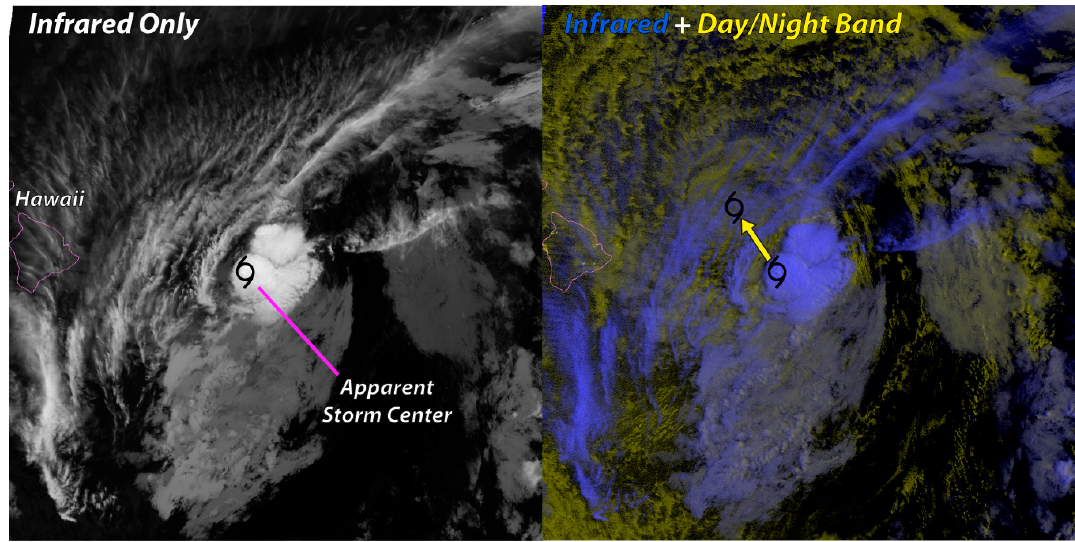
Figure 2. Nocturnal Tropical Cyclone tracking using VIIRS IR and DNB band, as presented on S-NPP VIIRS Imagery Validated Maturity Review by JSTAR Imagery EDR Team (Figure courtesy: Don Hillger, NOAA)